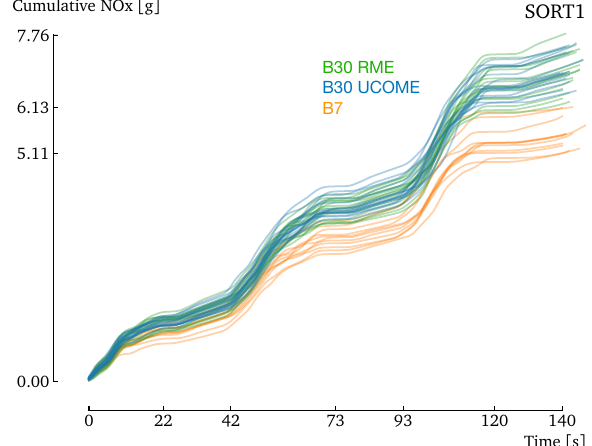
Figure 7. The cumulative NOx emissions along the SORT 1 test runs indicate an increase in NOx emissions for B30 RME and B30 UCOME compared to